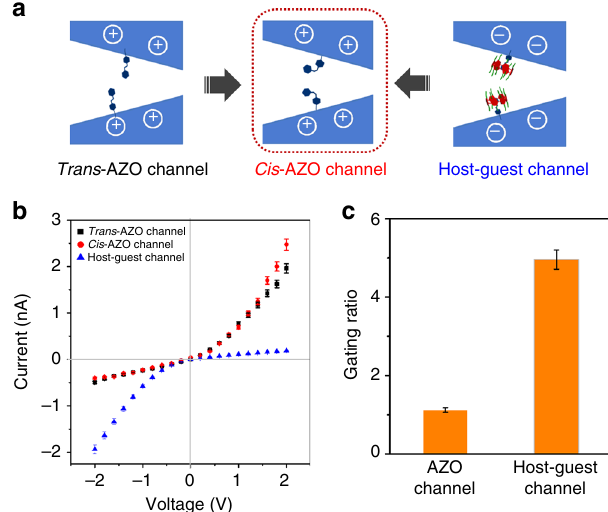
Fig. 5 The advantage of light-regulated nanochannels on the basis of host- guest system. a Schematic illustration of the light-responsive channel obtained through AZO modi fi cation. b The I – V curve of the light-sensitive channel: light responsive AZO-modi fi ed channel and light responsive host – guest systems modi fi ed channel. c The light-driven ionic gating properties: gating ratios ( Rg ) of the nanochannel calculated by the ionic current measured before and after UV light irradiation. Standard deviation is ± 5% and are used for describing the error bars . Each data in two cases are tested fi ve times,